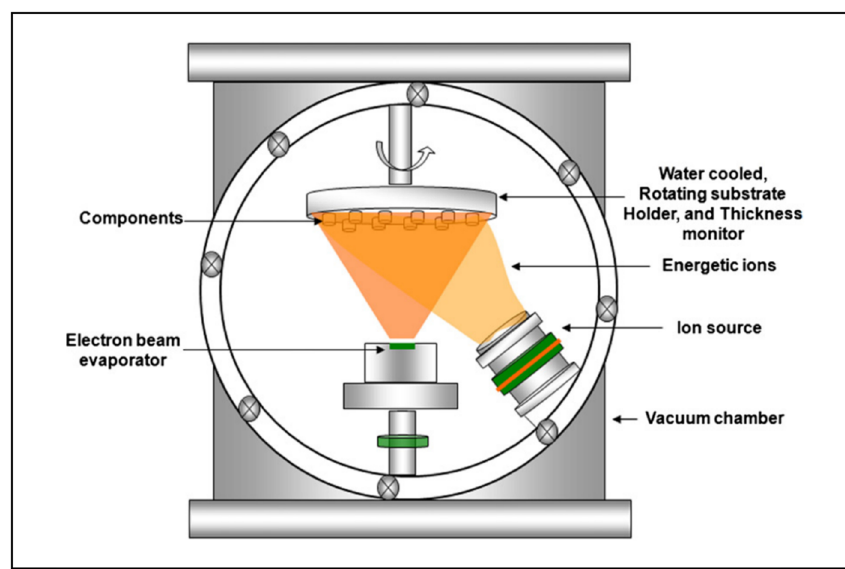
Figure 13: Schematic illustration of the IBAD system and process [ 105 ] . Copyright 2011, Elsevier ™ .